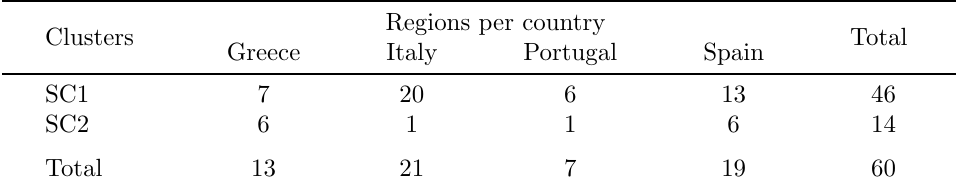
Table 9: Regions per country. Clustering based on the regions’ health and education